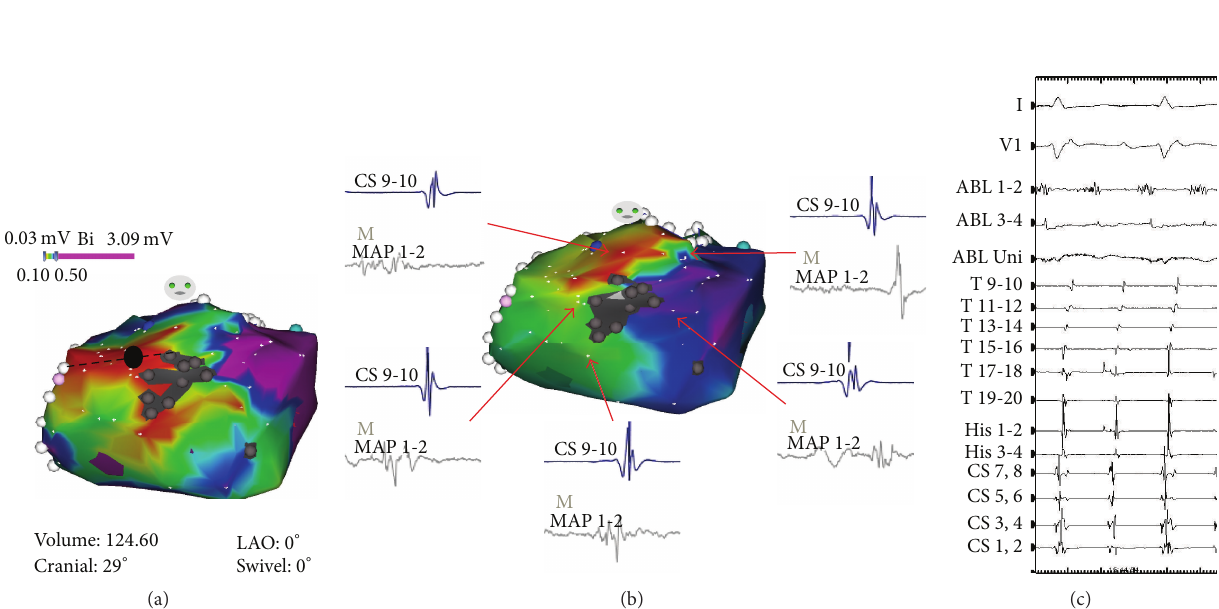
Figure 2: (a) The left atrial (LA) voltage map using a 3D electroanatomical mapping system. The grey area located at the anterior roof of the LA indicates the scar. The black circle indicates the site of entrainment pacing. The dotted line shows the linear ablation line between the LA scar and the ostium of the right upper pulmonary vein. (b) The LA activation map during AT. The arrowhead indicates local activity recorded around the scar. (c) Intracardiac ECG of the AT termination site recoded at the LA roof. ABL 1-2 indicates the distal electrode of the ablation catheter.